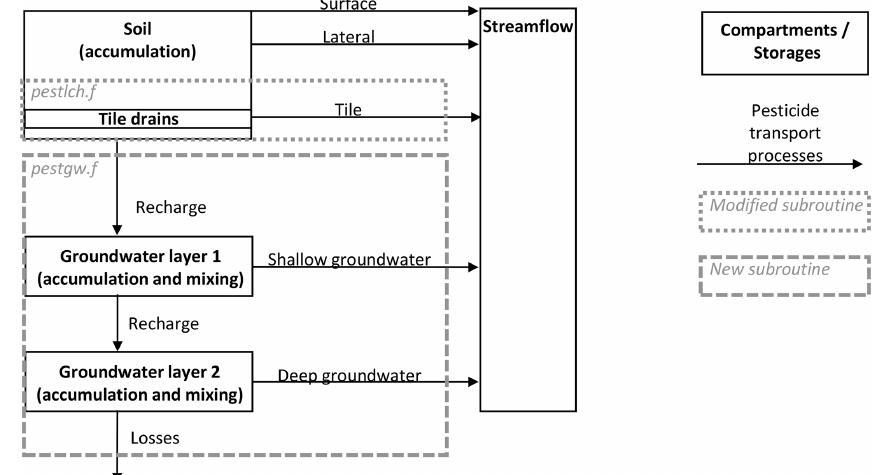
Figure 1. Flow chart of the newly implemented pesticide routing